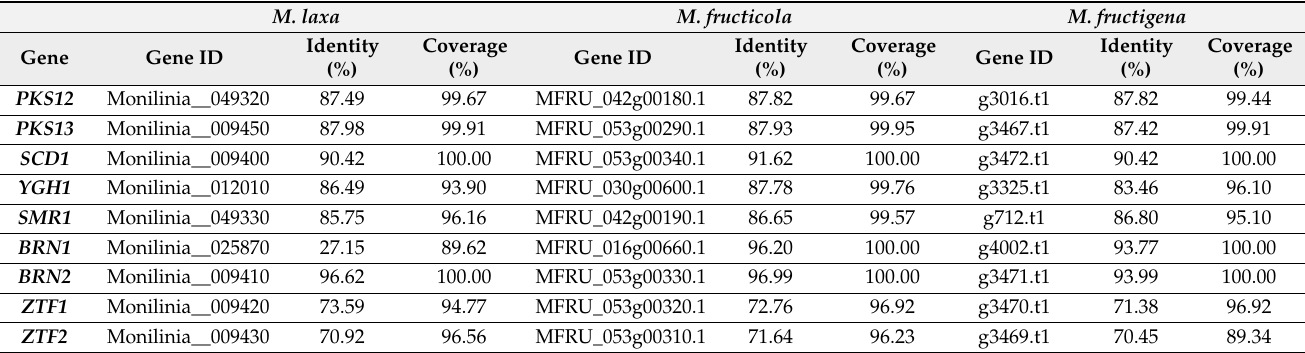
Table 1. Identification of DHN biosynthetic and regulatory genes from Monilinia laxa , M. fructicola , and M. fructigena obtained by BLAST analysis using previously described genes from Botrytis cinerea as query sequences. The results for Monilinia spp. indicate the ID of the corresponding gene, and the identity and coverage result from the BLAST